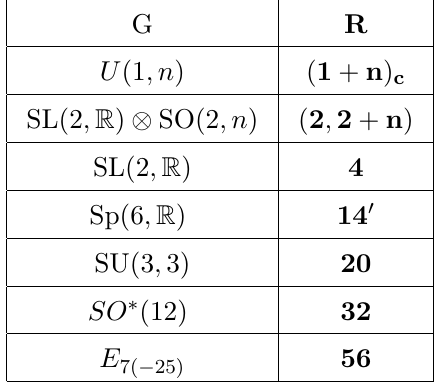
Table 3 . = 2 choices of groups N R . The last four lines refer to \magic